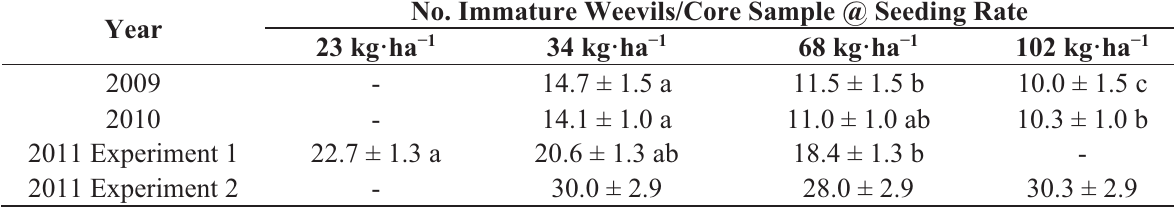
Table 1. Impact of seeding rate as a main effect on immature weevil densities in small-plot field experiments during 2009–2011 a